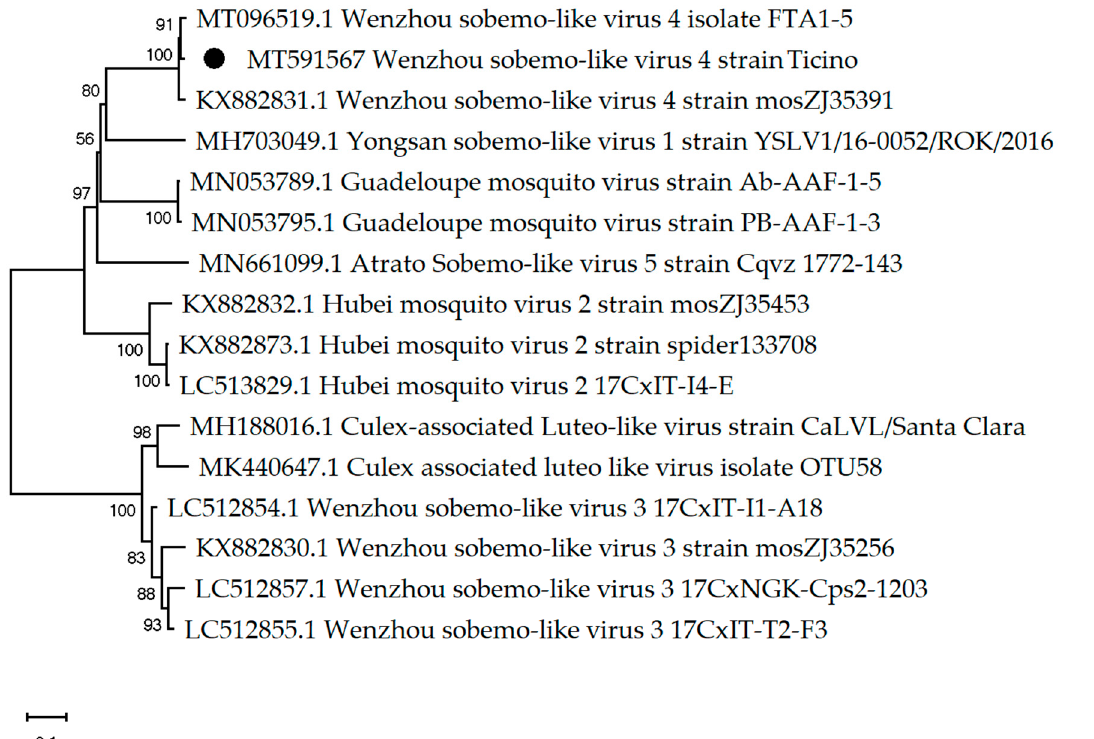
Figure 4. The phylogenetic tree of Wenzhou sobemo-like virus constructed using Table 2. parameter model. The percentage of replicate trees in which the associated taxa clustered together in the bootstrap test (1000 replicates) are shown next to the branches. The black dot indicates the genome sequenced in this study.